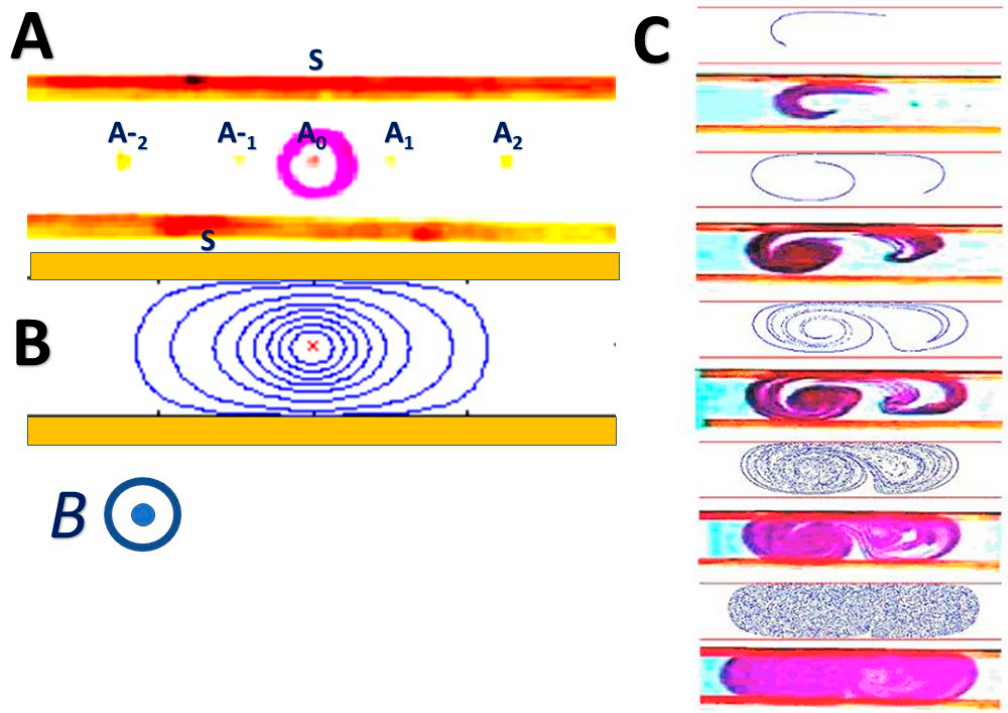
Figure 5. An example of a MHD stirrer [44]. ( A ) The conduit of Figure 1A is equipped with electrodes along its side walls and point electrodes located along its axis and denoted A k . The electrodes along the side walls are connected and denoted S. When a potential difference is applied between the central electrode A 0 and the side wall electrode S, fluid circulation results as shown with dye ( A ) and in theoretical predictions ( B ). By alternately engaging the two agitators A -1 -S and A +1 -S, the device alternates between two flow patterns, resulting in chaotic advection (Lagrangian Chaos) and efficient stirring ( C ). The image ( C ) depicts observations of the evolution of a blob of dye in theoretical simulations and in experiments.